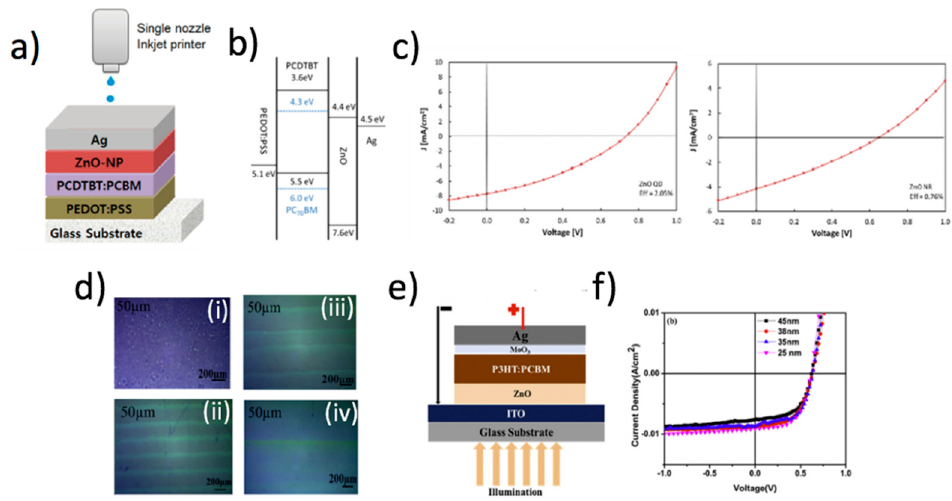
Figure 18. Applications in photovoltaics. ( a ) Device architecture and ( b ) schematic energy level diagram of a Glass / PEDOT:PSS / PCDTBT:PC 70 BM / ZnO-NP / Ag all-inkjet-printed solar cell. ( c ) J-V characteristics under illumination of the organic solar cells (OSCs) based on ZnO ETL fabricated with ZnO quantum dots (left panel) and nanorods (right panel). The respective PCEs are indicated. Reproduced with permission from Reference [146]. Copyright © 2014 WILEY-VCH. ( d ) Optical micrographs of ZnO inkjet-printed films with 50 µ m drop spacing using inks of viscosity (i) 2.07 cP, (ii) 2.43 cP, (iii) 2.90 cP, and (iv) 4.70 cP. ( e ) Architecture of the inverted OSC device structure, and ( f ) J-V characteristics